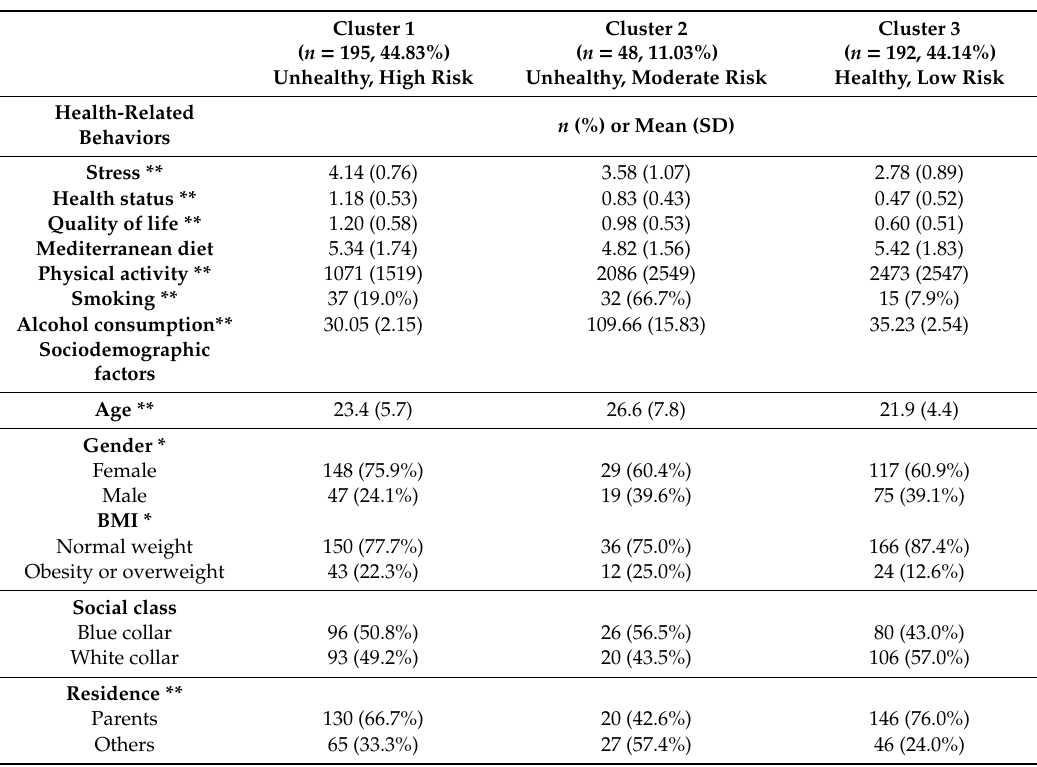
Table 5. Characteristics of the three clusters ( n =